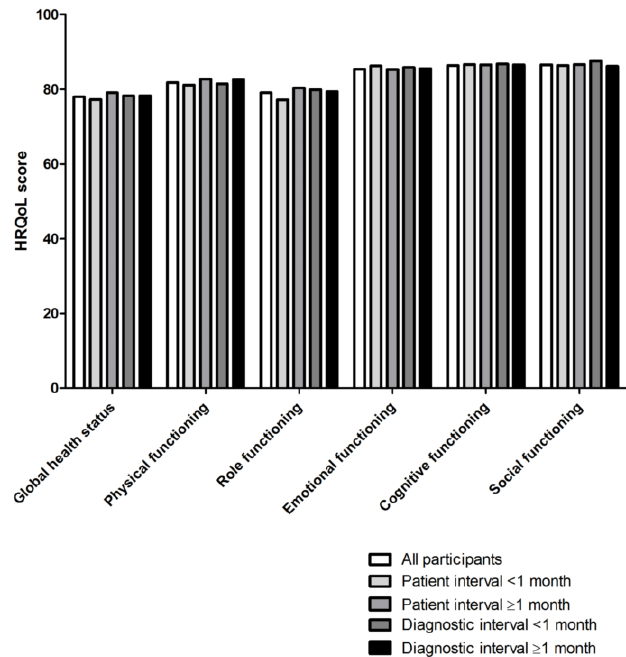
Figure 1. Mean scores on HRQoL.